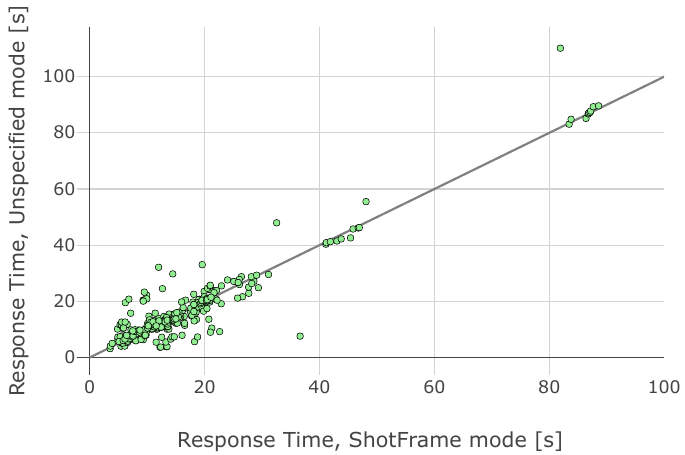
Figure 10. Scatter plot of the CVI response time of two label detection modes, Unspecified and Shot&Frame, fixing all the other variables.